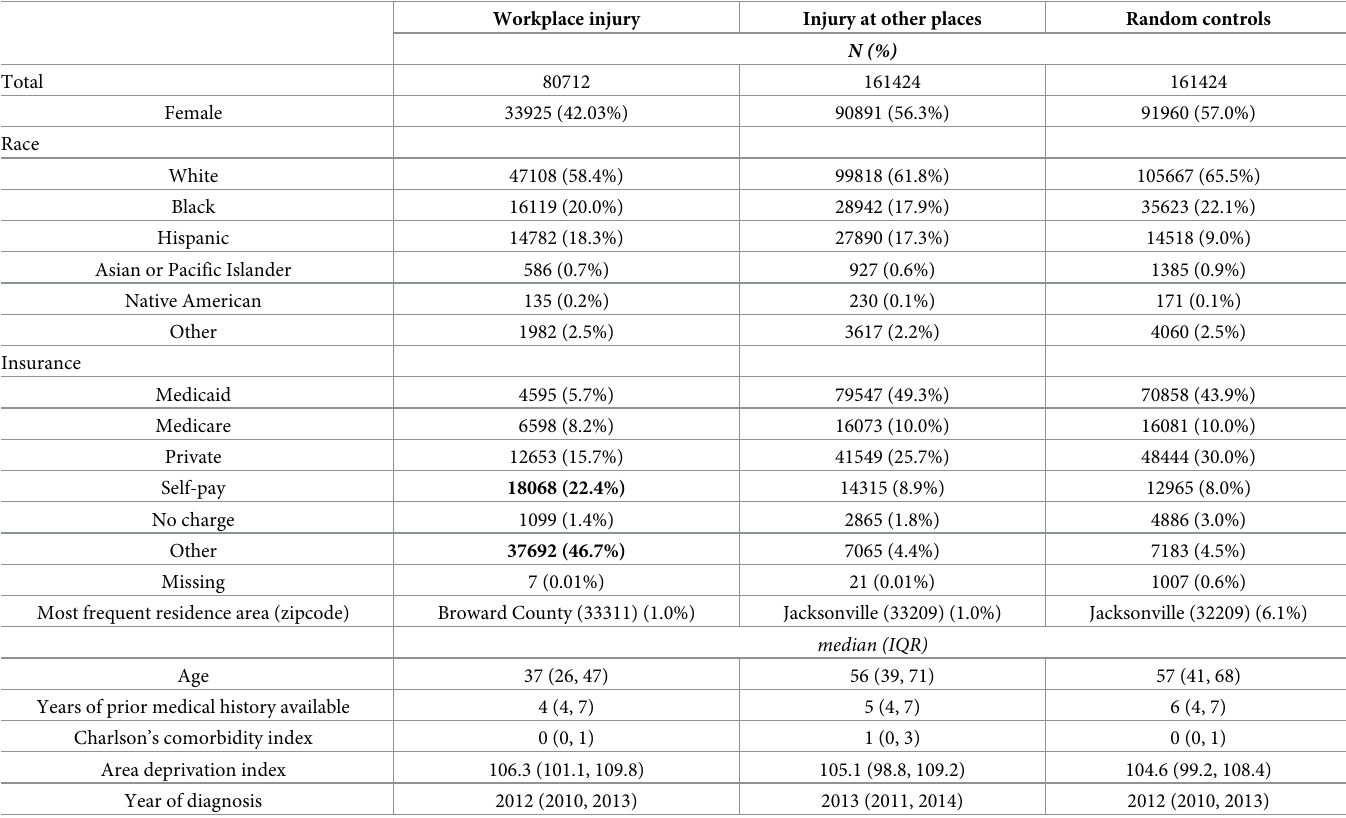
Table 1. Characteristics of the study